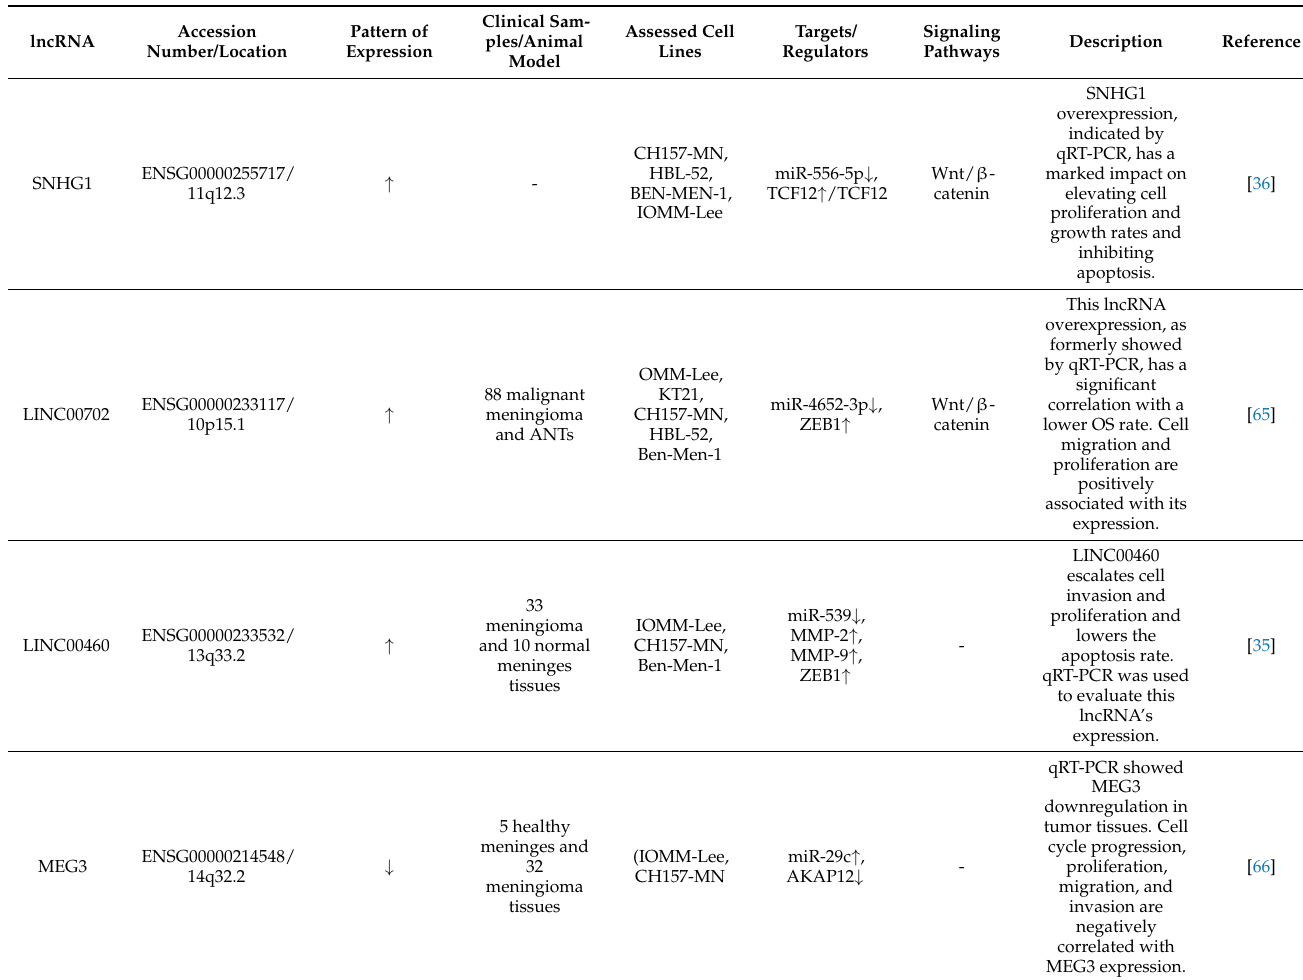
Table 5. LncRNAs and meningioma (ANTs: adjacent non-tumor